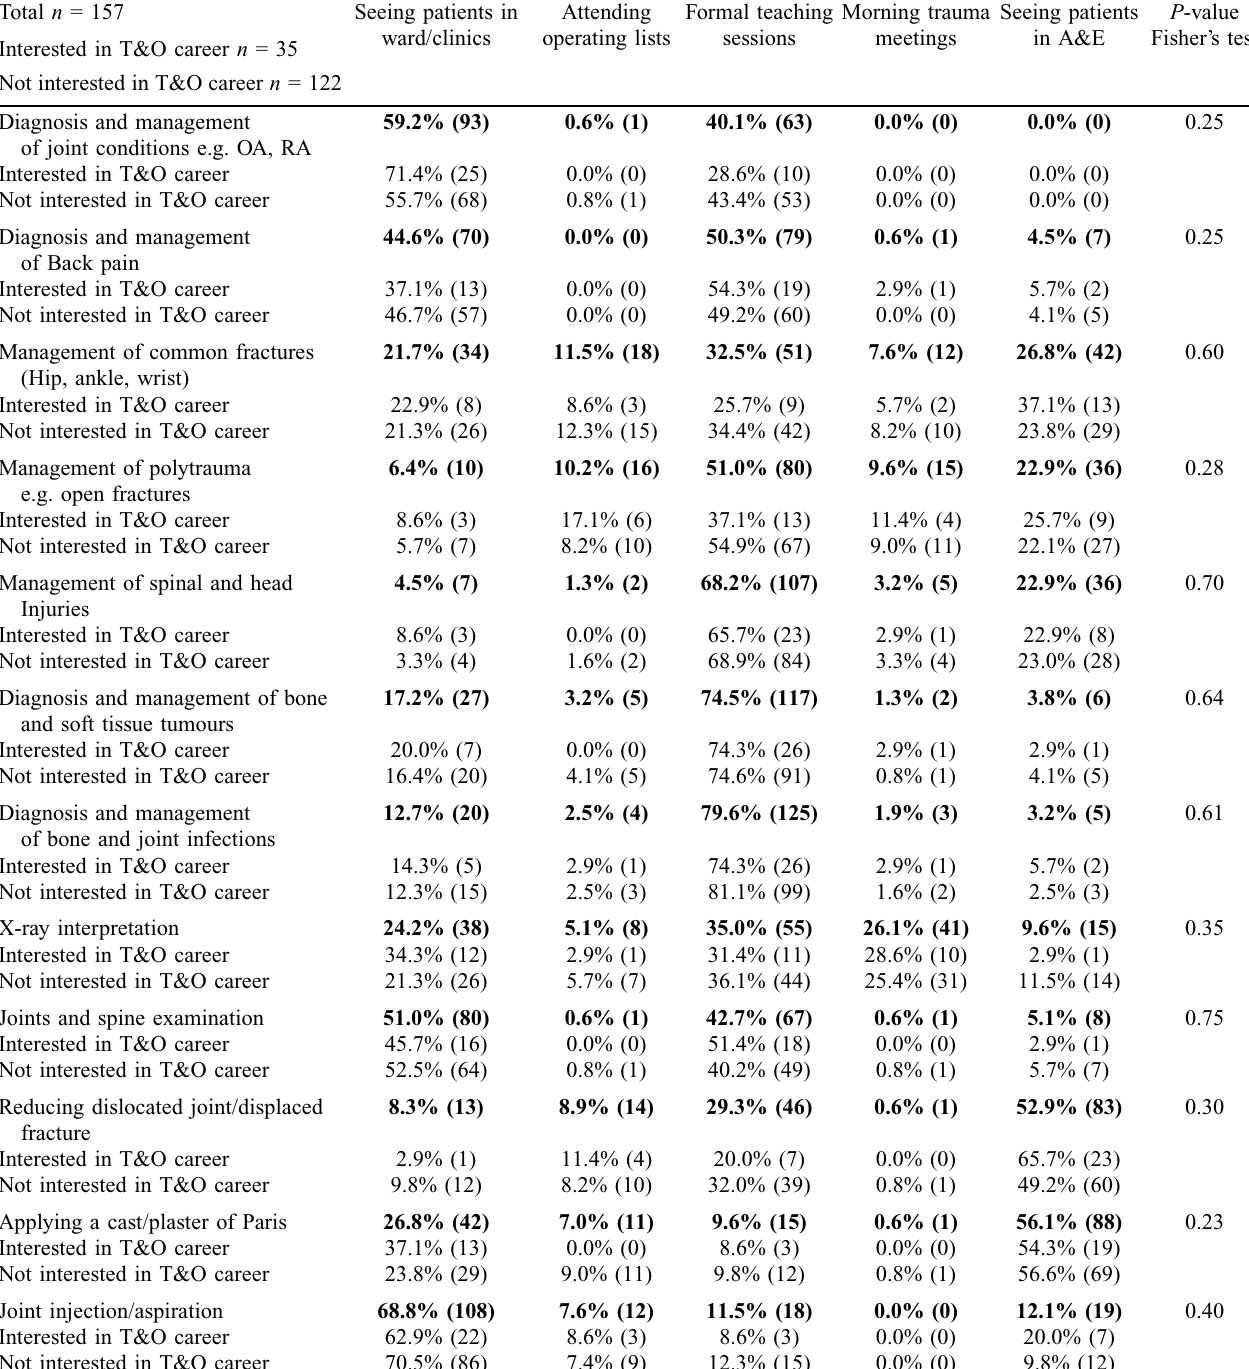
Table 2. Student rated educational benefit of learning environments in relation to key musculoskeletal curricular